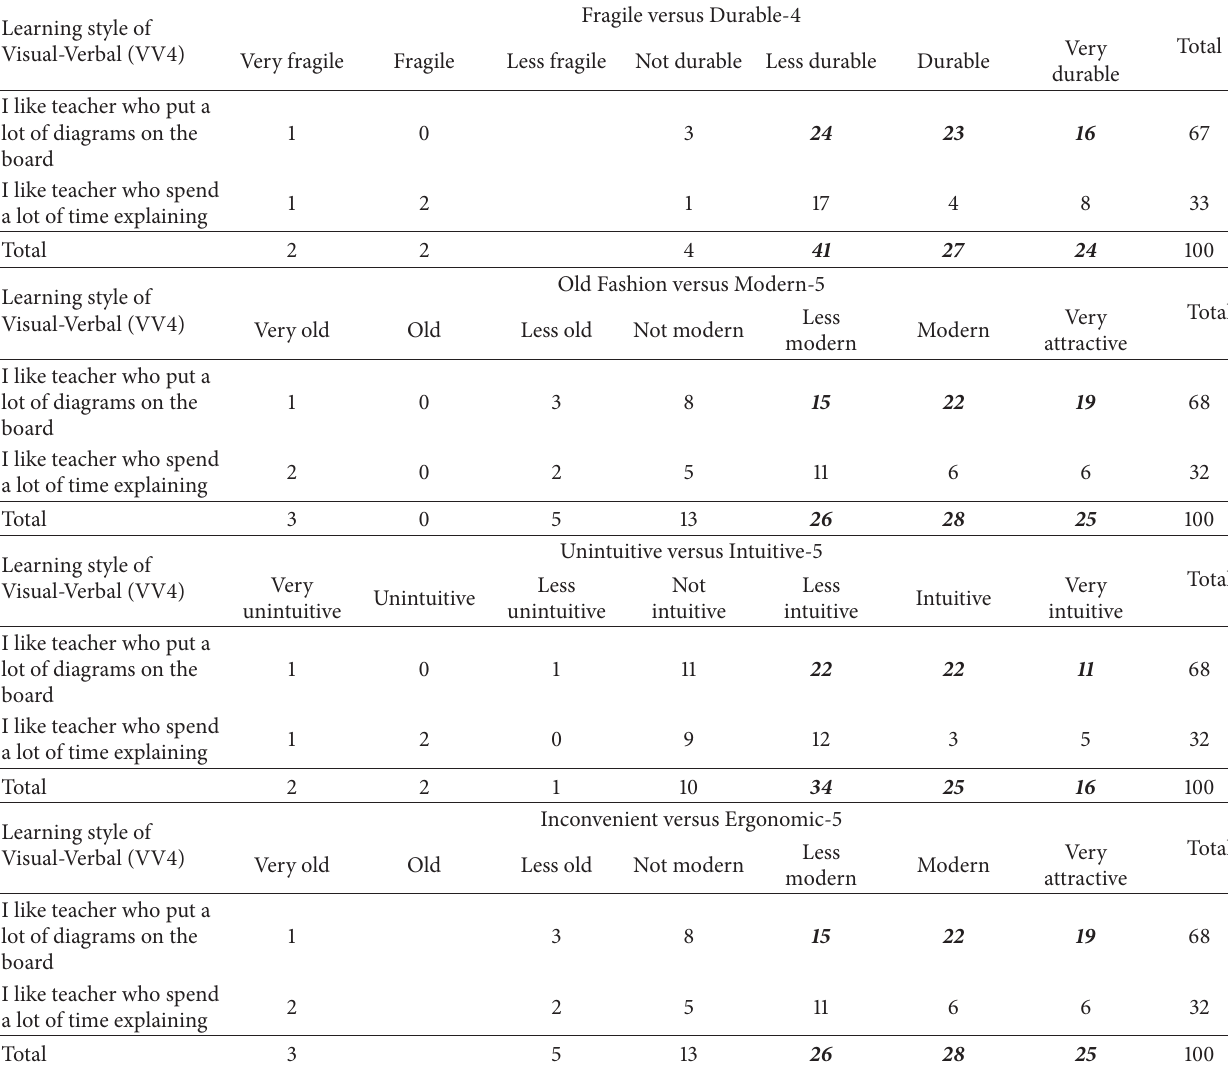
Table 21: The Interpretation of Design no. 5 versus the the students preferences related to teaching delivery (VV4) (Based on Kansei words Fragile-Durable, Old Fashion-Modern, Unintuitive-Intuitive,